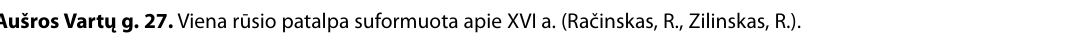
Table 1. buildings and complexes built during the r­enaissance